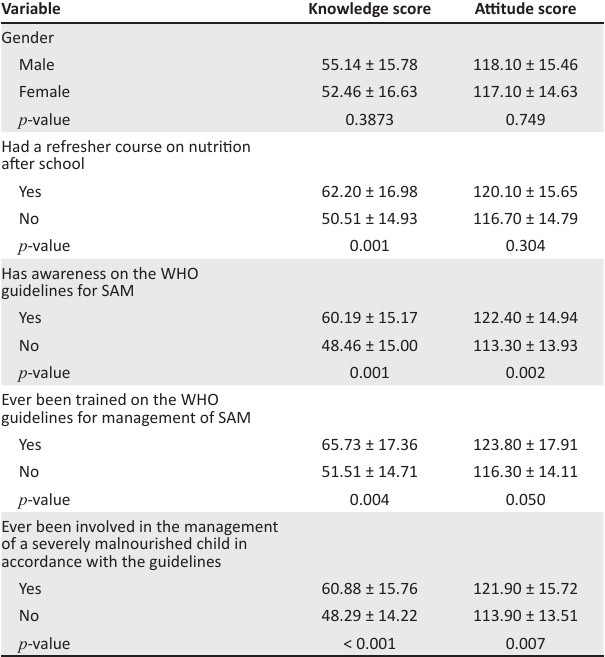
TABLE 5: Factors associated with nurses’ knowledge and attitude scores.